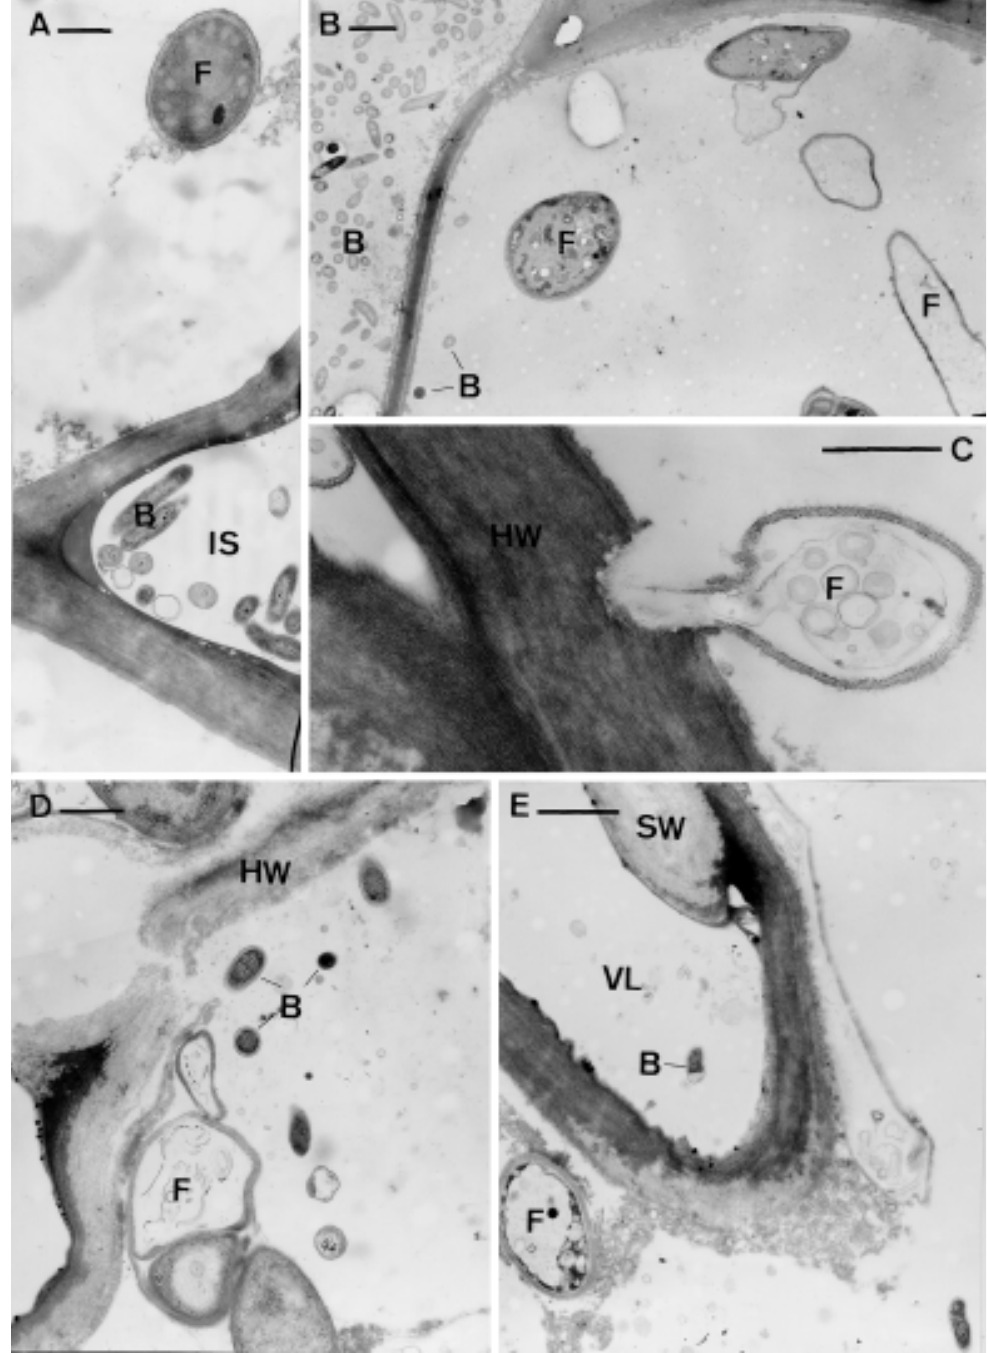
Fig. 2. TEM sections of potato cv. Spunta tissues 7 days after bacterization with Bacillus thuringiensis 55T and challenge with Fusarium roseum var. sambucinum . Bacterial vegetative cells are present intercellulary (A), intrac- ellularly (B, D), and in the vascular tissues (E). Most fungal cells near the bacterium show severe damage (B–E) and cell-wall breakdown (C). Note the absence of typical structural host reactions (A–E). Bar = 1 mm. B, bacterium; F, fungus; HW, host wall; IS, intercellular space; SW, secondary wall; VL, vessel